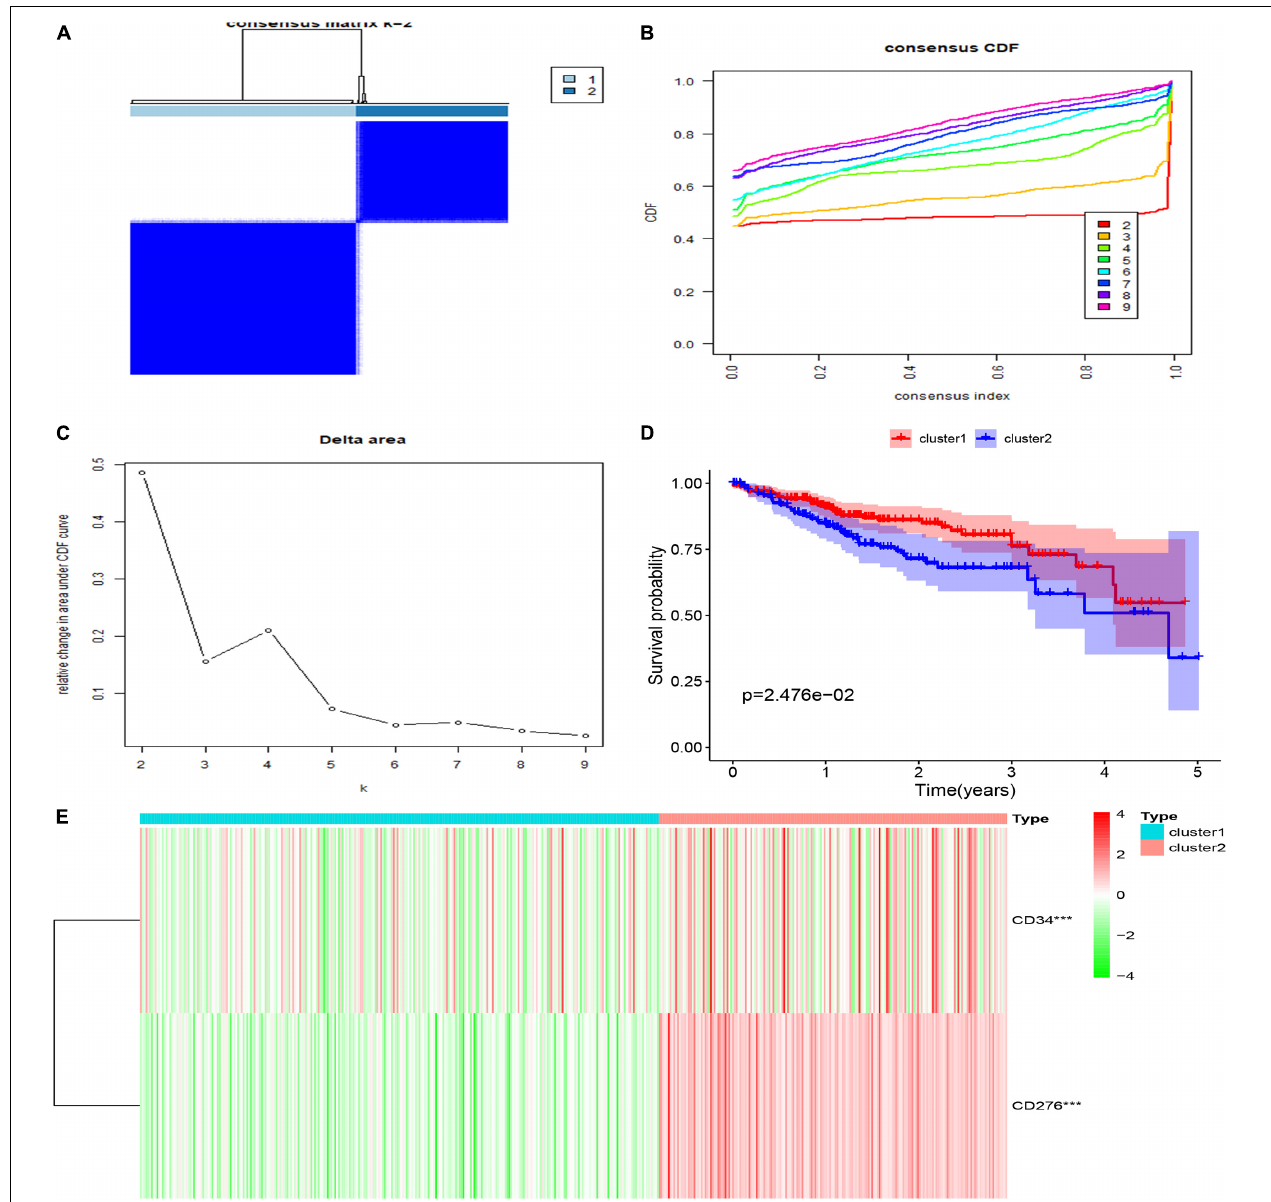
FIGURE 3 | Clustering and survival analysis based on TCGA database. (A–C) The results of consistent cluster matrix, cumulative distribution function curve, and relative change of area under the curve showed that the expression of CD34/CD276 could be divided into two types of CRC samples. (D) K-M survival curve showed that patients with Cluster1 showed higher survival ability than those with Cluster2 ( P < 0.05). (E) Compared with Cluster1, the expression of CD34/CD276 was up-regulated in Cluster2 (*** P <